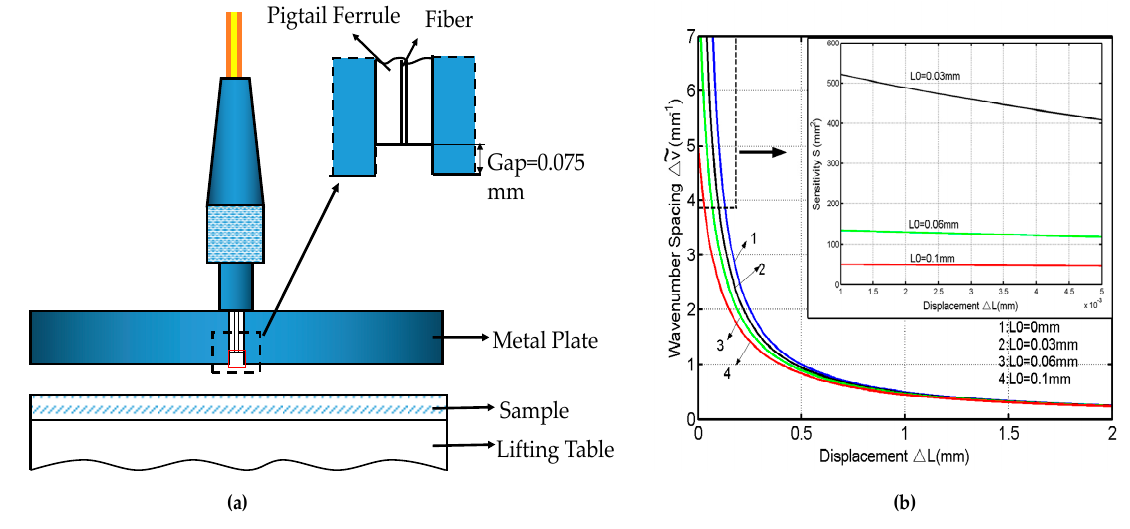
Figure 5. ( a ) Structure of the special design sensing head; ( b ) Simulation results with various L 0 . The inset: the sensitivity as a function of micro-scale displacement. Copyright (2010) Optics Communications, from Reference [50].